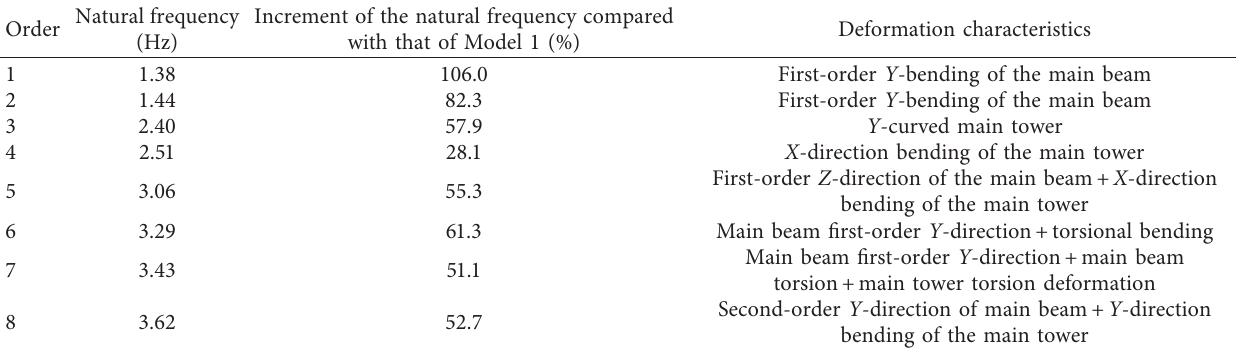
Table 4: Natural frequency and deformation characteristics of Model